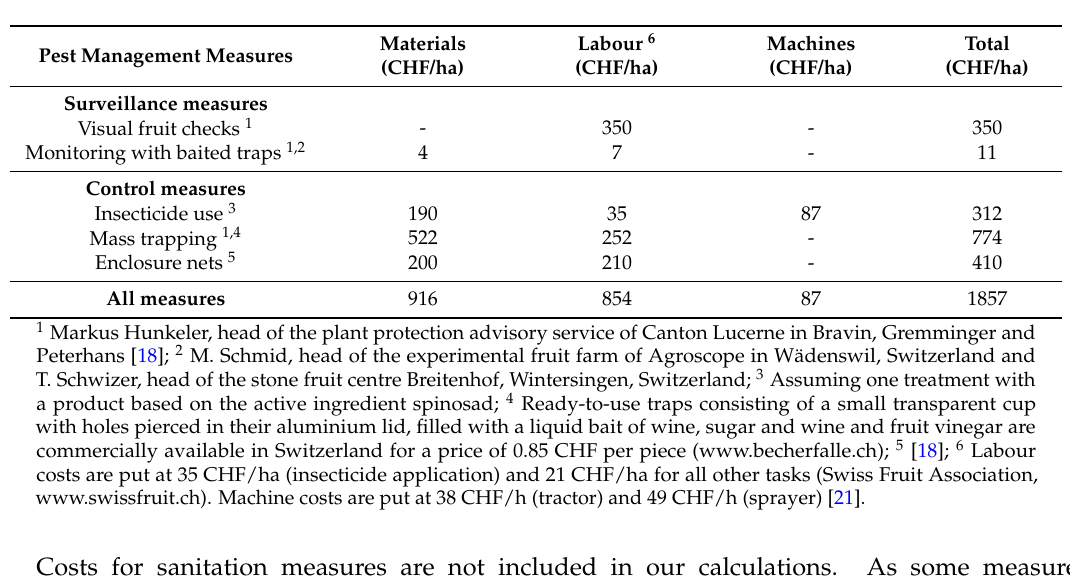
Table 5. Costs of pest management measures against Drosophila suzukii in sweet cherry production in